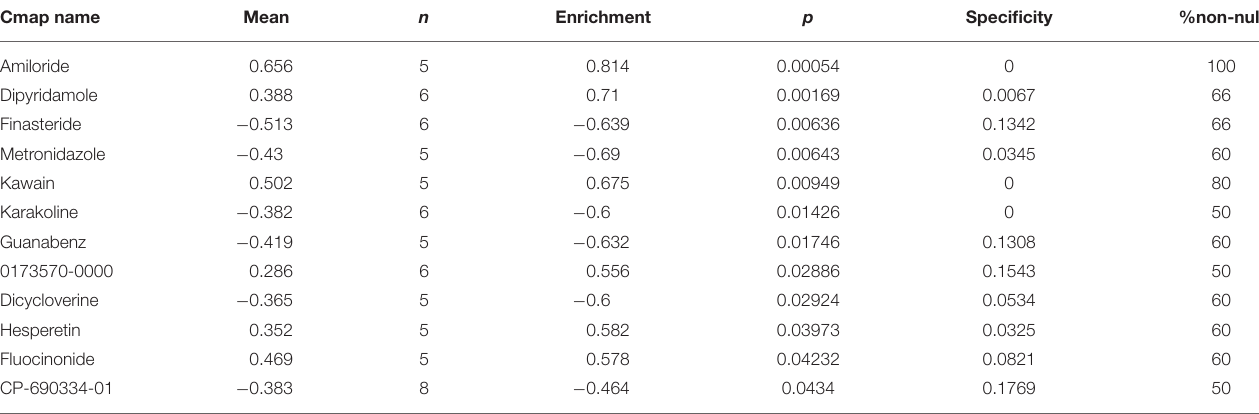
TABLE 3 | Results of CMap analysis based on DEGs in